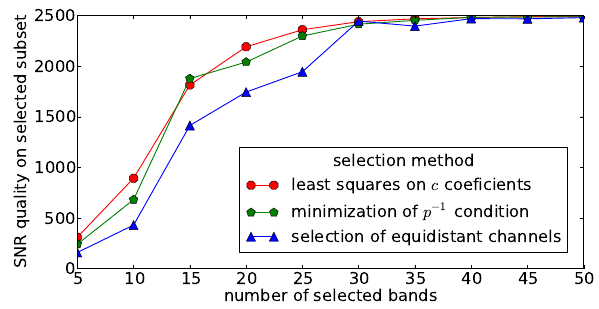
25 Fig. 9. Results of the mean reconstruction SNR for the three dis- cussed spectral subset selection Fig. 9. Results of the mean reconstruction SNR for the three discussed spectral subset selection tech- niques.